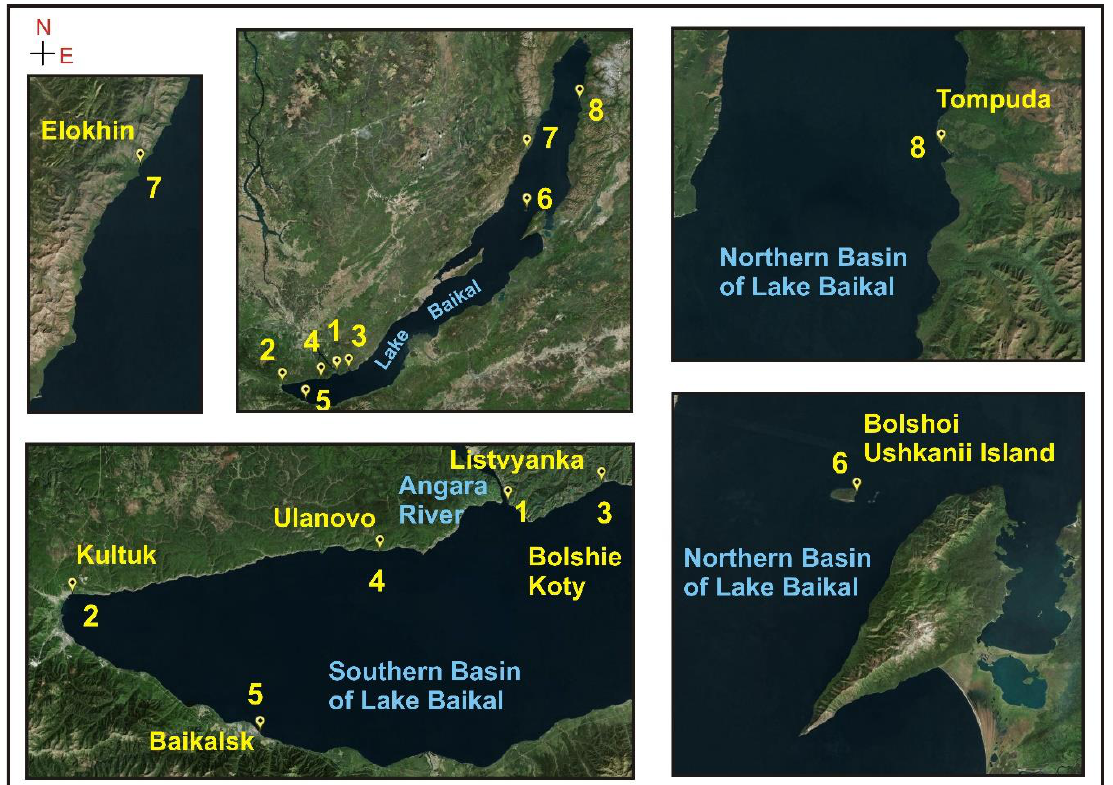
Figure 1. Scheme of Lake Baikal and the sampling sites of Lubomirskia baikalensis (class Demospongiae, order Spongillida, family Lubomirskiidae). Live sponges from the site No. 1 were transported into aquariums, and sponges from the sites No. 2 – 8 were frozen immediately.